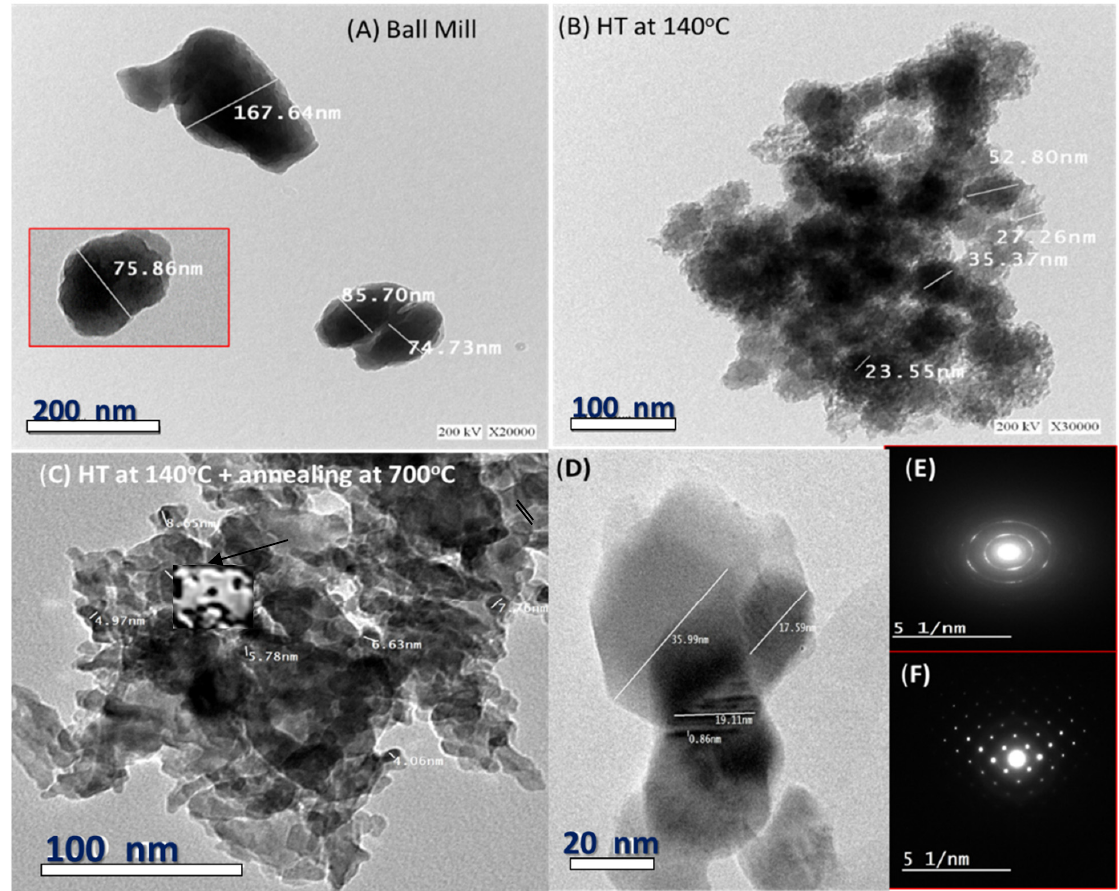
Figure 3. HR-TEM of the RW 0.03 after ( A ) ball mill, ( B ) hydrothermal technique at 140 °C, and ( C , D ) annealing at 700 °C; ( E , F ) selective-area electron diffraction (SAED) after annealing. annealing at 700 ◦ C; ( E , F ) selective-area electron diffraction (SAED) after